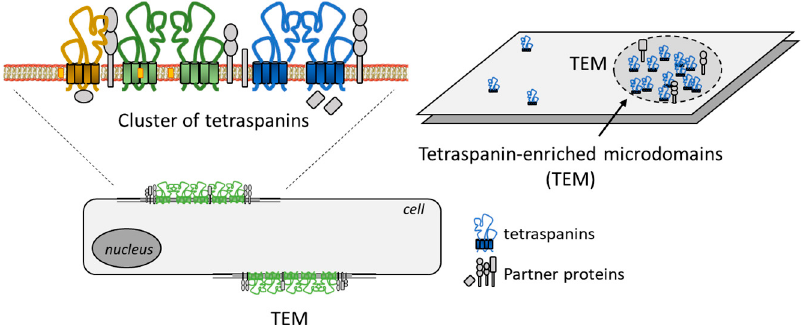
Figure 2. Representation of the clustering of tetraspanins to form microdomains at the plasma membrane, associating divers tetraspanins and partner proteins. The tetraspanin web is a dynamic structural organization at the cell surface, including promiscuous and specific interactions [32].